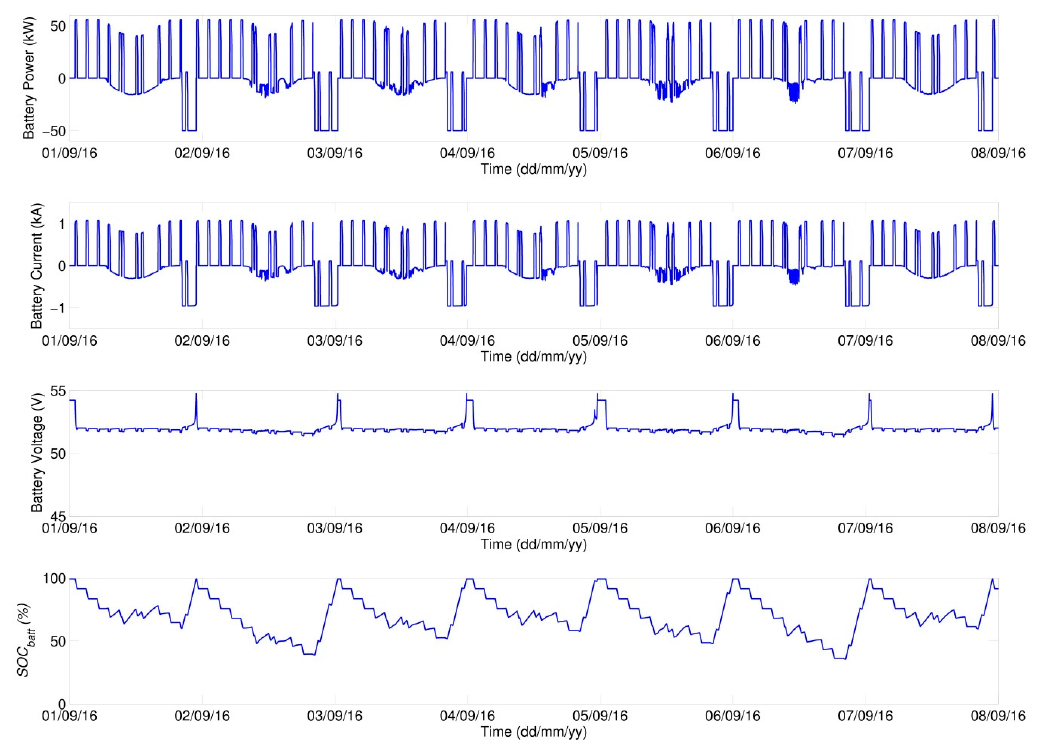
Figure 20. Resulting profiles for simulation of operating states of accumulation, scenario B.